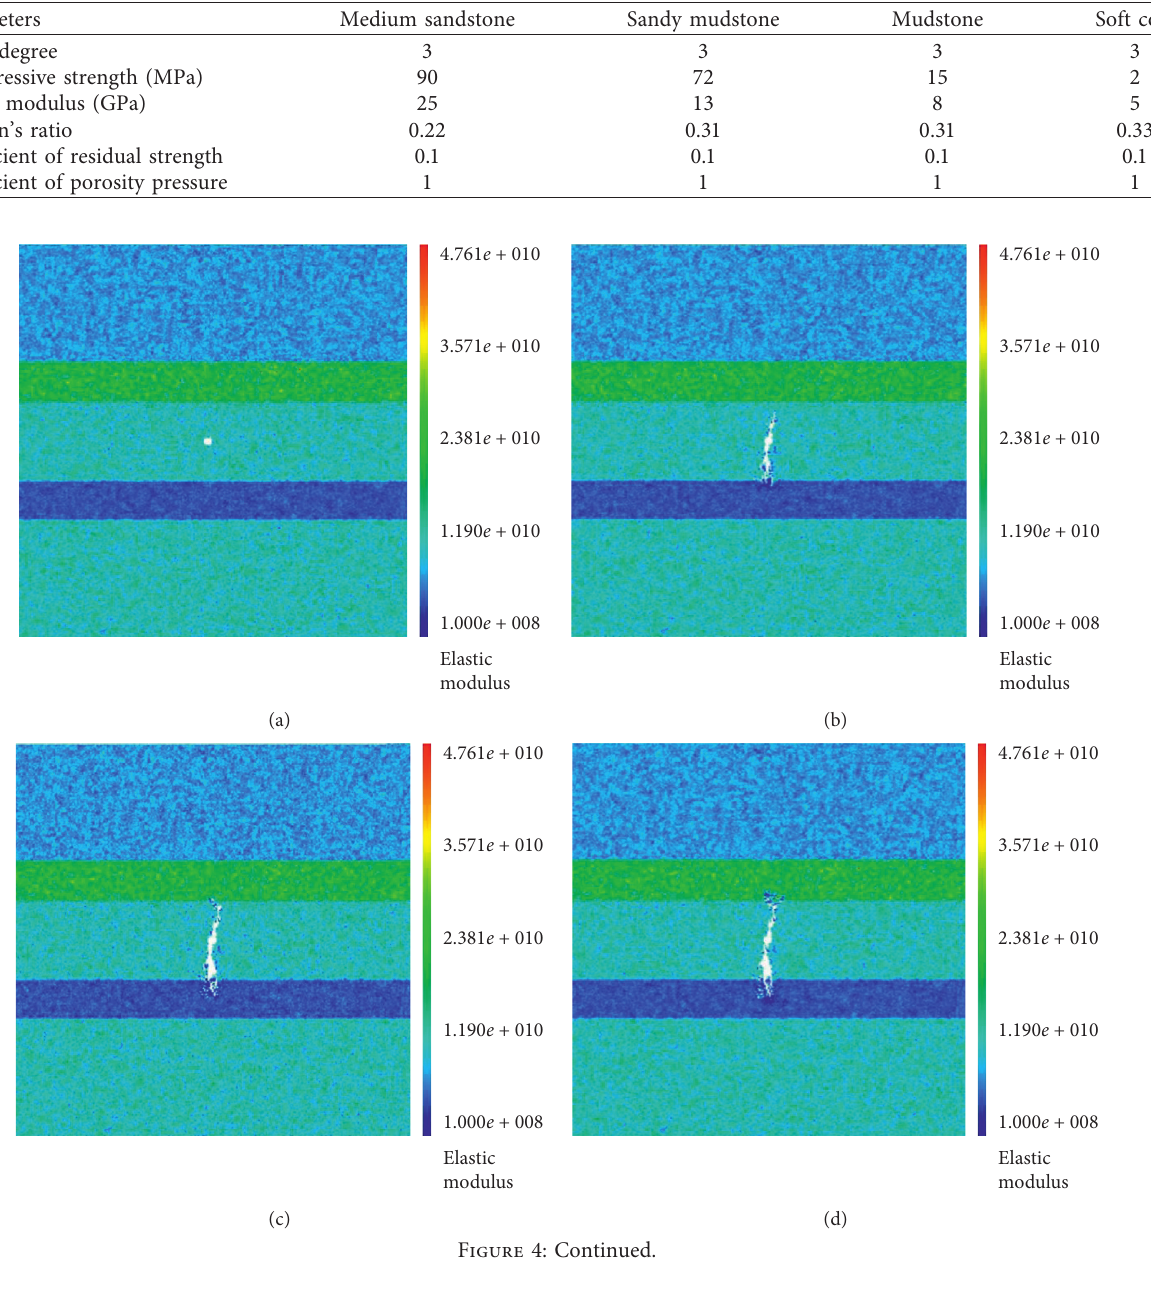
Table 1: Mechanical parameters of numerical simulation